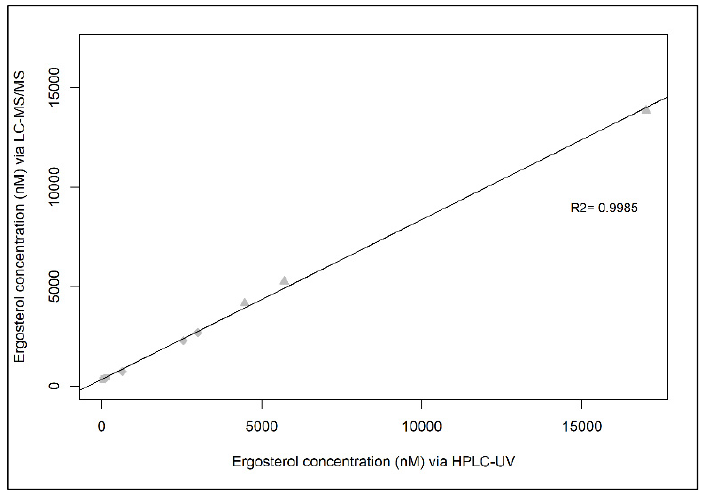
Figure 5. Ergosterol content in nM detected via HPLC-UV vs. LC-MS/MS from the marine fungal isolate Sakaguchia dacryoidea covering three growth phases (lag, exponential, and stationary).